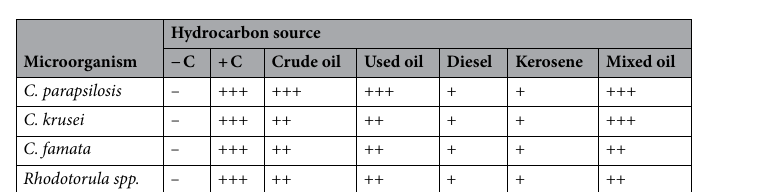
Figure 3. The oil biodegrading ability of different yeast isolates on different hydrocarbons. The strains were grown in MSM supplemented with 0.1% Tween 80, and 0.6 mg/ml DCPIP, incubated at 25 °C for 15 days, then the colorimetric changes in DCPIP were measured at 420 nm. ( A ) C. parapsilosis, ( B ) C. krusei, ( C ) C. famata , and ( D ) Rhodotorula spp. ( E ) Bar chart of the growth rate of all the isolated strains, 15 days post-incubation with different hydrocarbons.